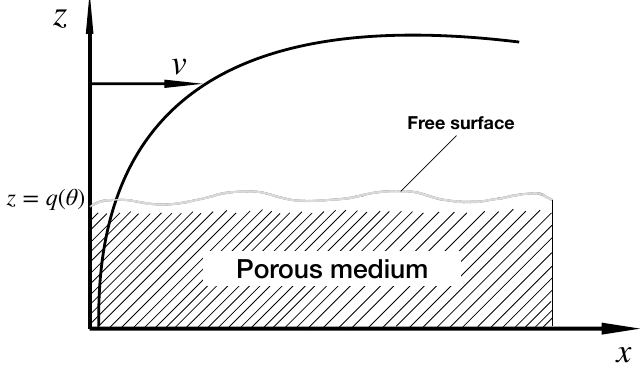
Figure 3. Fluid flow over the porous